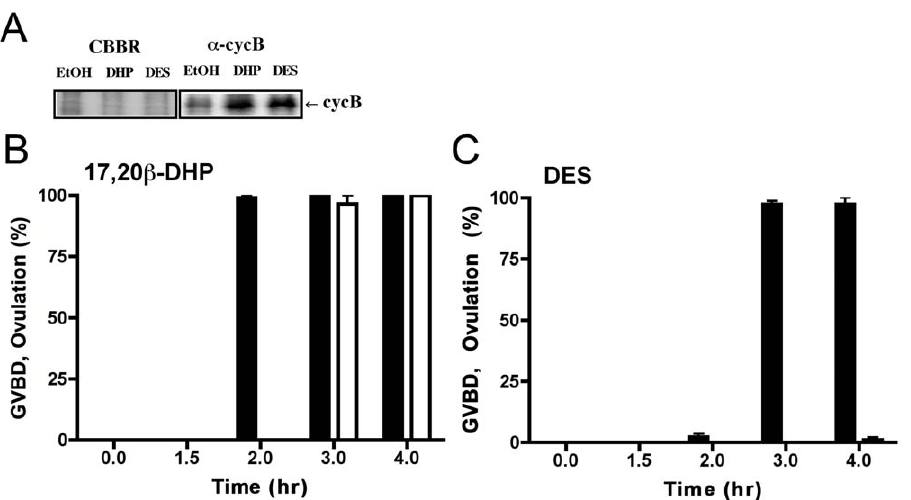
Figure 2. Characterization of 17,20 b -DHP- and DES-induced oocyte maturation invivo . (A) 17,20 b -DHP and DES induce accumulation of cyclin B. Extracts were prepared from twenty oocytes after incubation with ethanol, 17,20 b -DHP or DES for four hours. Extracts of each treatment were separated by electrophoresis under denaturing conditions (10.0% gel) and stained with Coomassie Brilliant Blue (CBBR), or immuno-stained with anti-goldfish cyclin B polyclonal antibody after electroblotting ( a -cycB). The arrow indicates a band representing cyclin B. Time-course change of GVBD and ovulation induced by 17,20 b -DHP and DES. Oocyte maturation induced by 0.01 m M 17,20 b -DHP (B), 5 m M DES (C) in vivo . At each time point, ovarian fragments were dissected from sacrificed females and %GVBD (closed column) and %ovulation (open column) was determined by scoring oocytes that had become transparent and formed fertilization membranes. Each value represents the mean of data from three different females. Vertical lines indicate standard deviation.